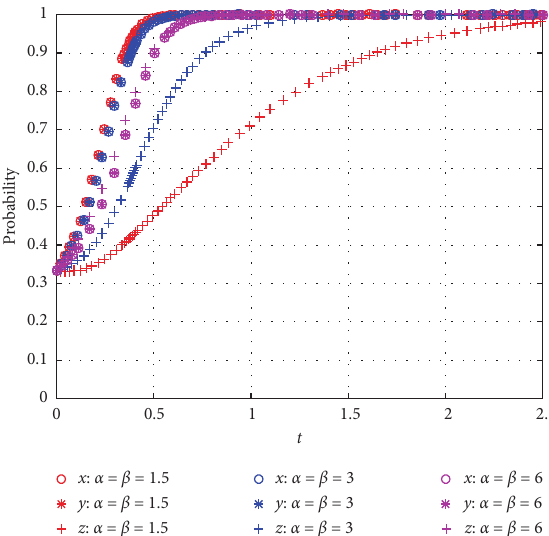
Figure 8: Evolution paths of scenario 4 under different transfer